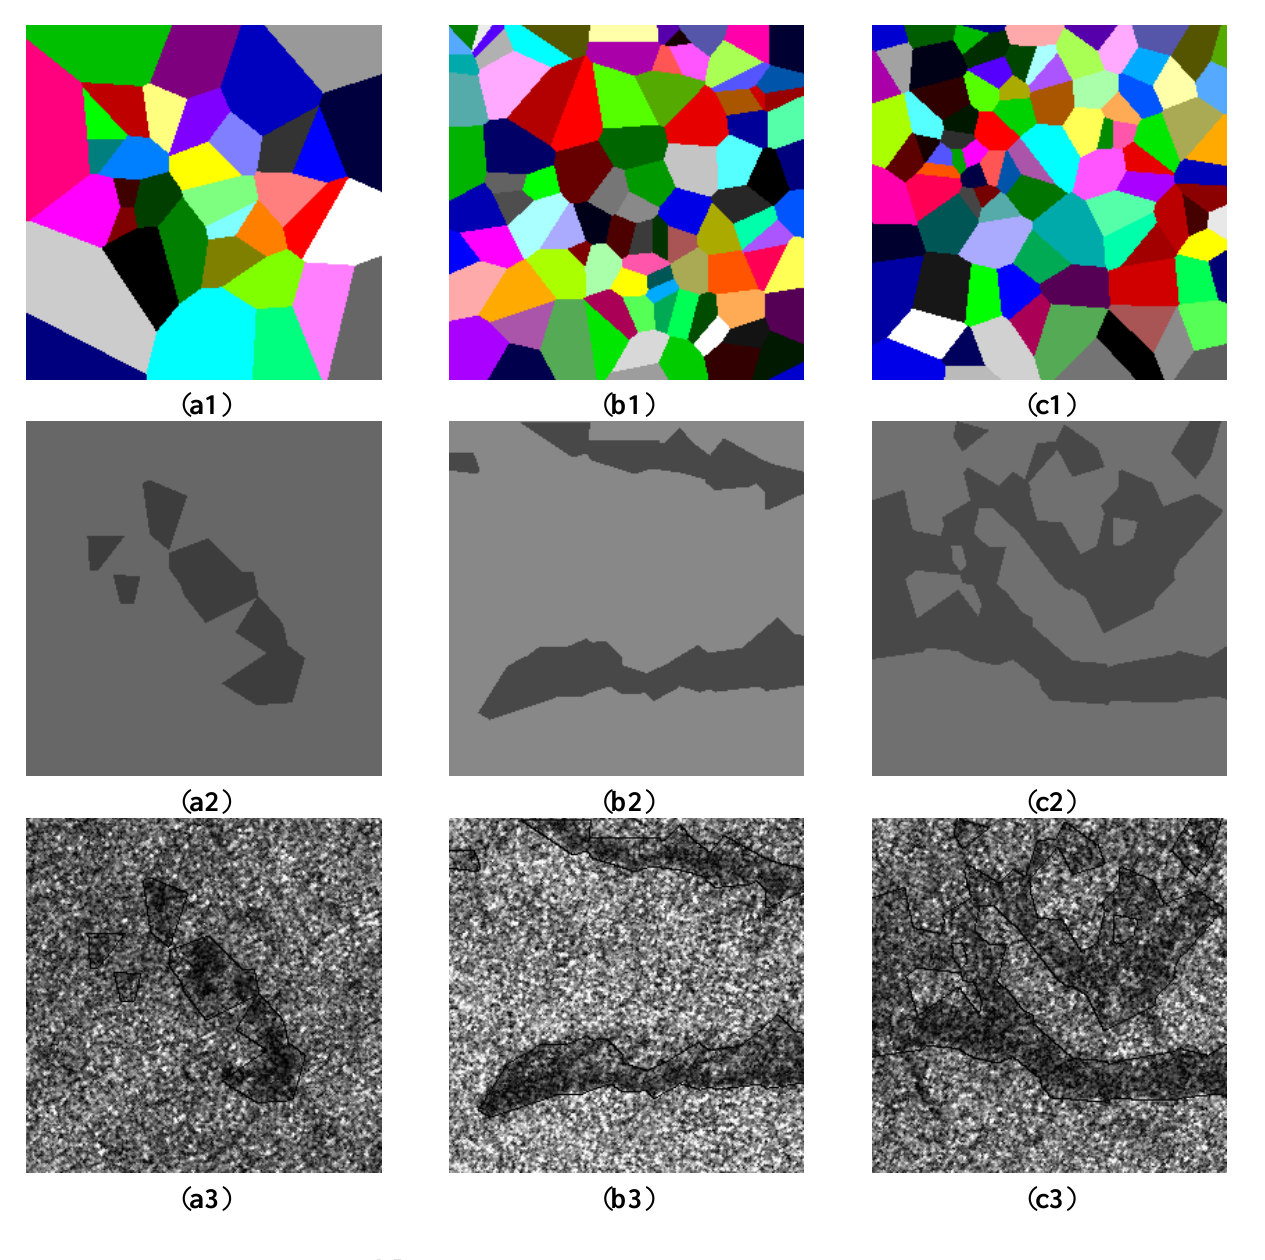
Figure 8. Final partition ( a1 ), ( b1 ), ( c1 ) and segmentation ( a2 ), ( b2 ), ( c2 ) of testing images. Darker regions in ( a2 ), ( b2 ), ( c2 ) indicate oil spills. Overlaying the outlines of extracted darker regions on test images ( a3 ), ( b3 ), ( c3 ).